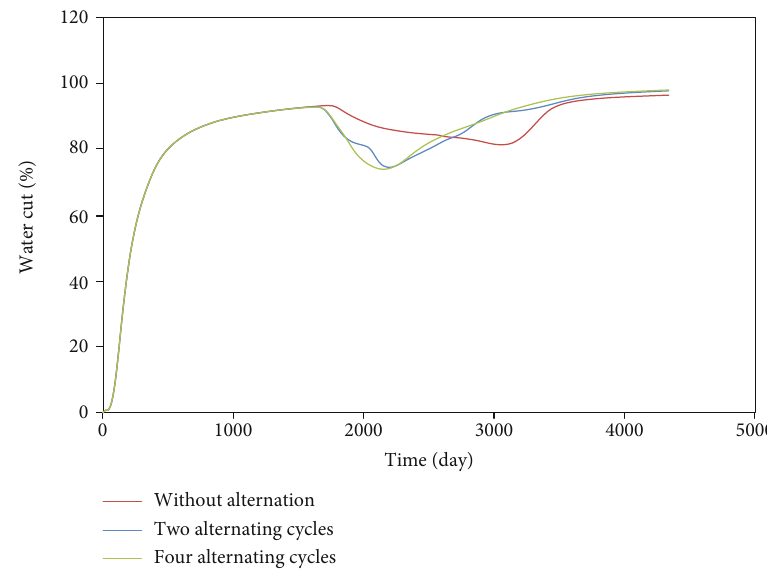
Figure 14: Water cut in di ff erent